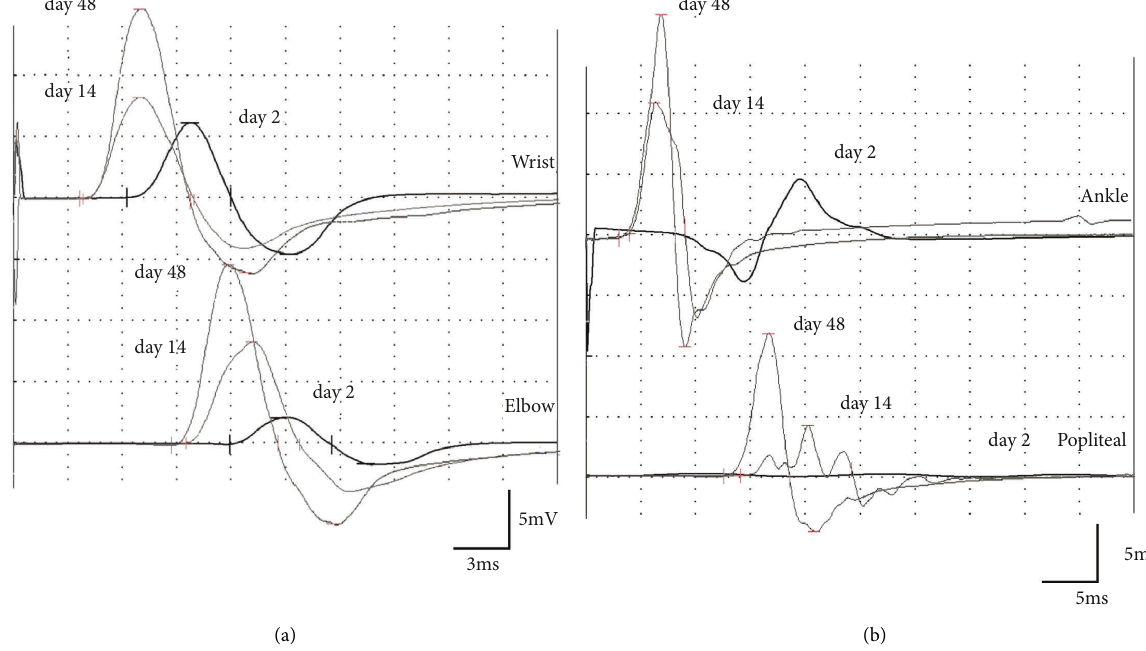
Figure 2: Serial nerve conduction tracings in the case. Serial recordings of compound muscle action potentials (CMAP) of the left median nerve (a) and the left posterior tibial nerve (b) on days 2, 14, and 48. Prolonged distal latencies (DL) were shown in the left median nerve and posterior tibial nerve on day 2. Distal CMAP was within the normal range; however, proximal CMAP was eliminated in the posterior tibial nerve and decreased in the median nerve. DL and CMAP improved over time on day 14 and day